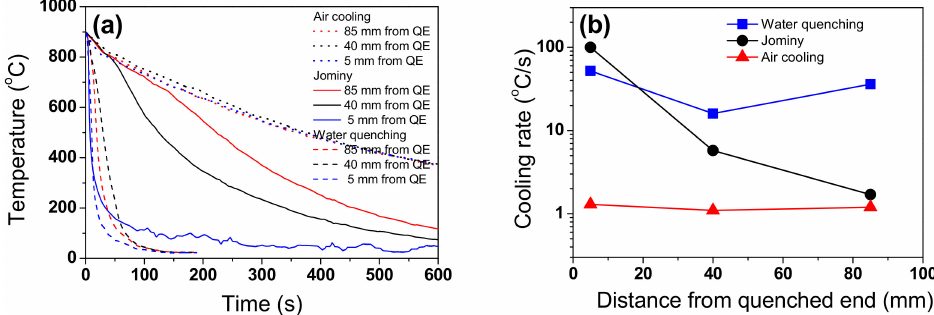
Figure 4. Comparison of ( a ) temperature profiles and ( b ) cooling rates of the standard Jominy specimen with the different cooling conditions: water quenching, standard Jominy cooling, and air cooling. Cooling rate was measured at the temperature of 700 ◦ C.